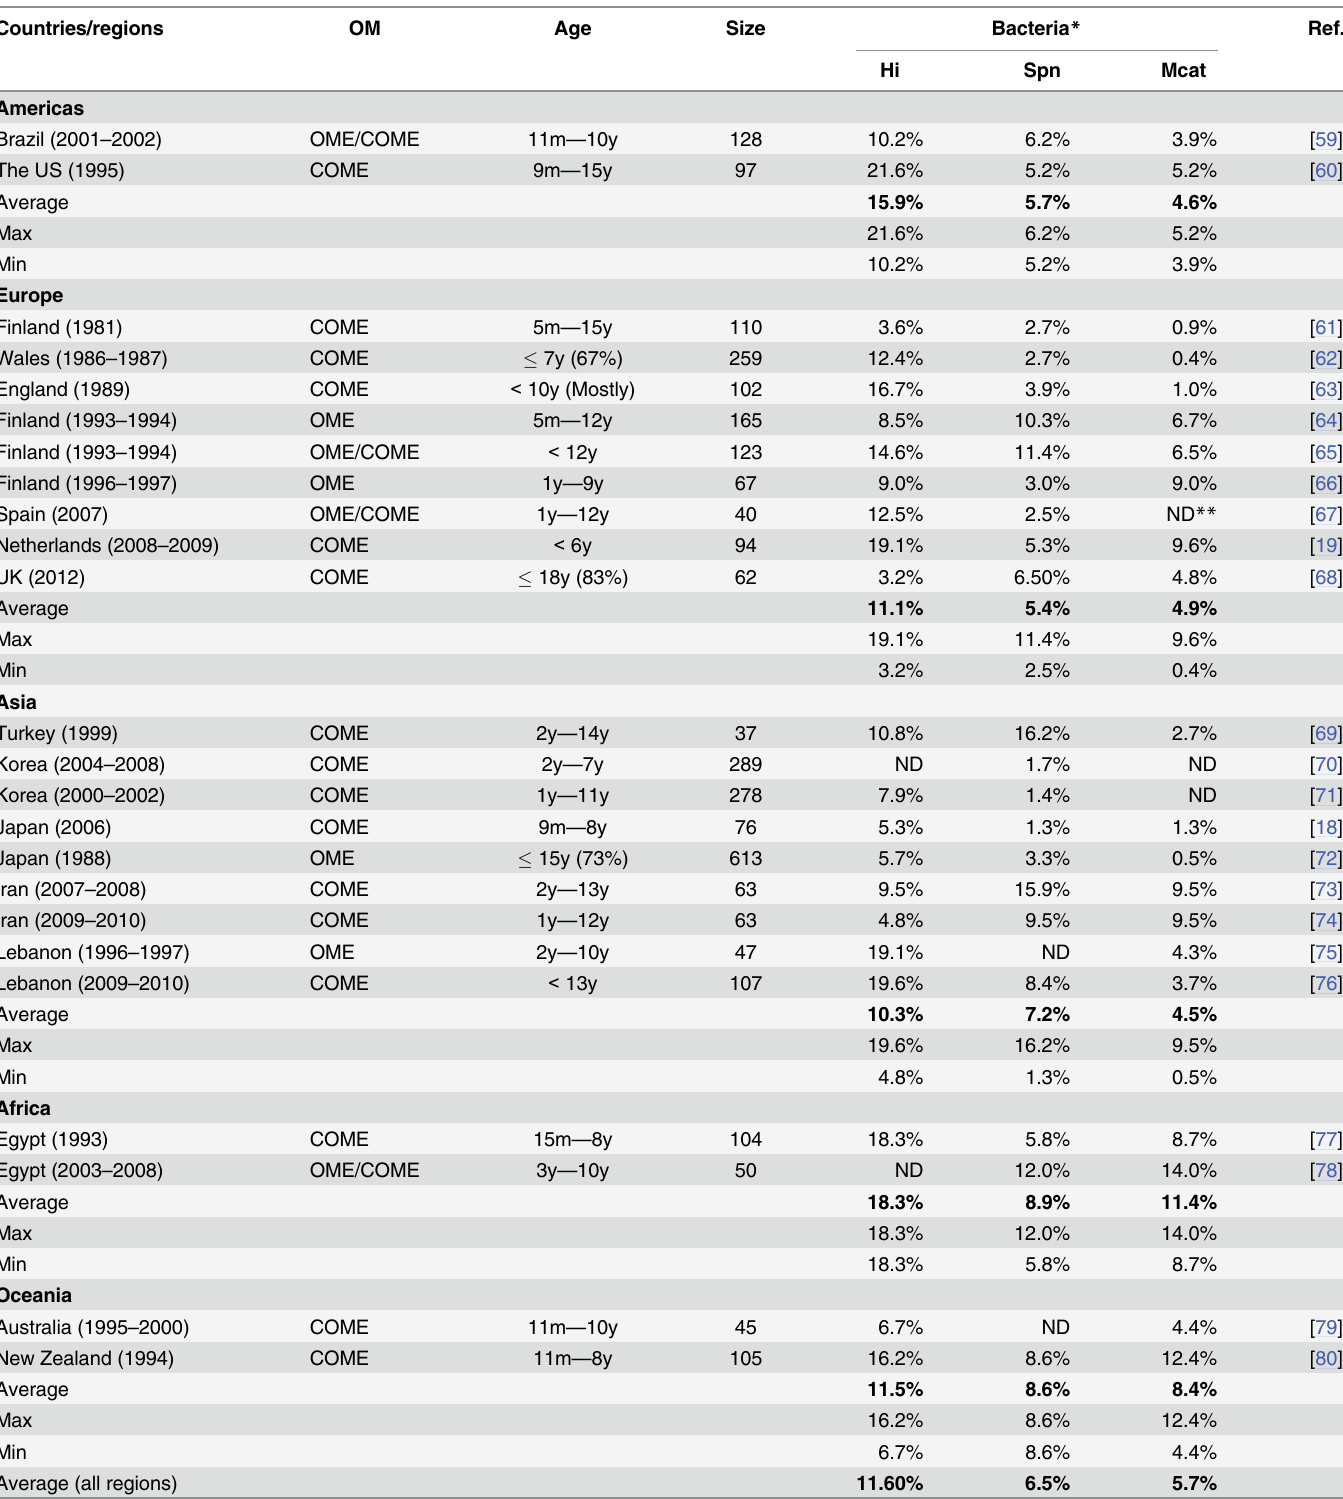
Table 3. S . pneumoniae , H . influenzae and M . catarrhalis detected from MEF of patients with OME/COME.